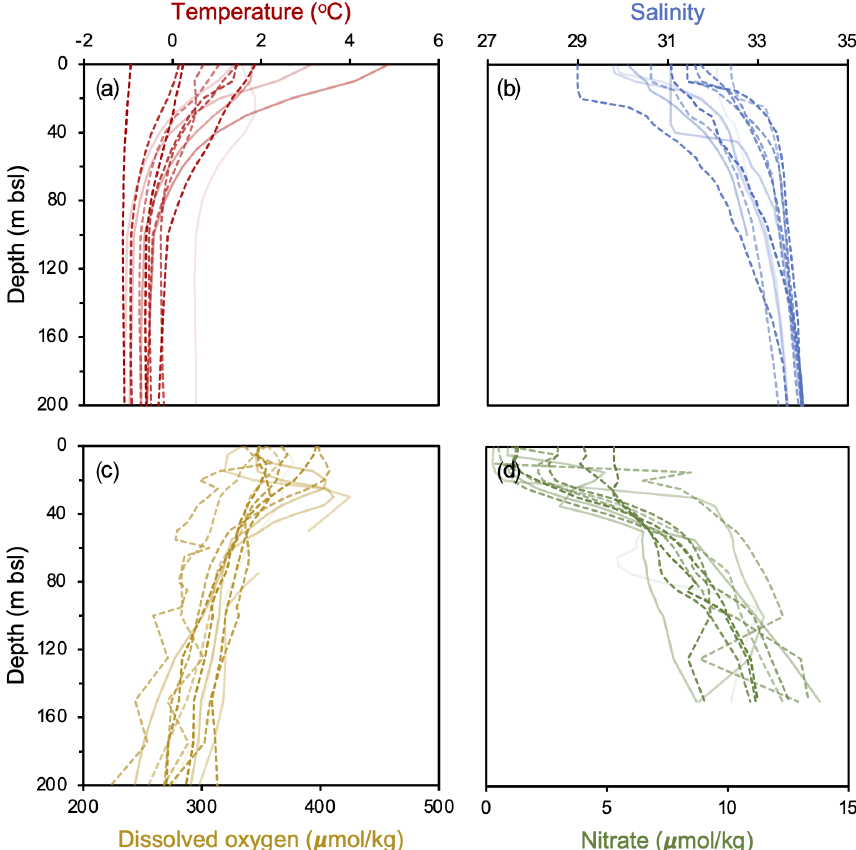
Figure 2. WOA18 Annual 2007–2017 oceanographic variables from Baffin Bay against depth (mb.s.l.). Individual profiles are from each study site, where darker (lighter) colors reflect sites farther north (south) and dashed (solid) lines denote those within (outside) the modern limits of the NOW. Data from Garcia et al. (2018a, b), Locarnini et al. (2018), and Zweng et al.